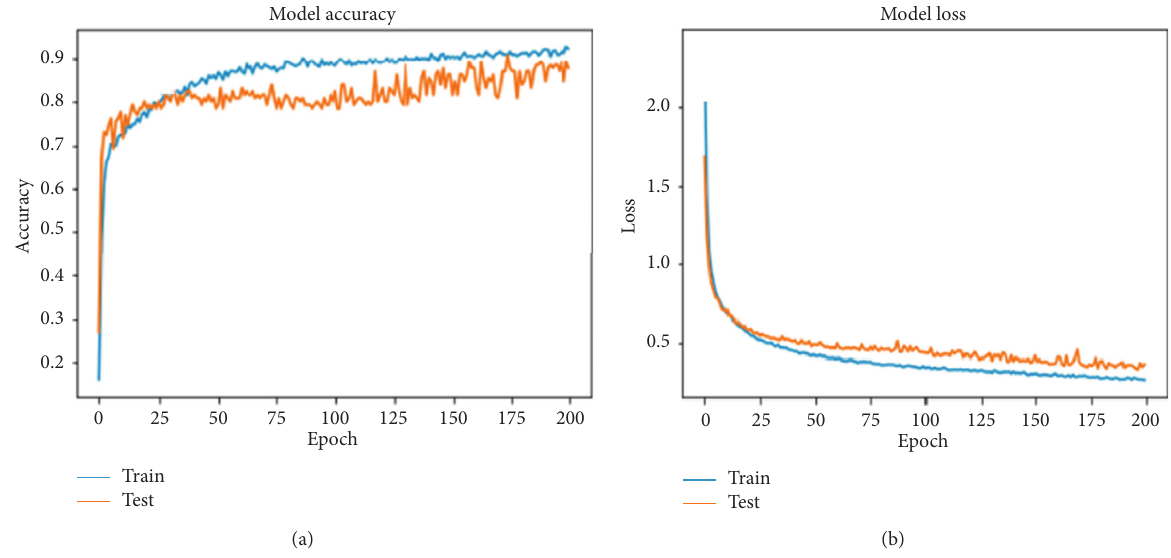
Figure 13: Model accuracy and model loss for M-learning model 2. (a) Model 2 accuracy. (b) Model 2